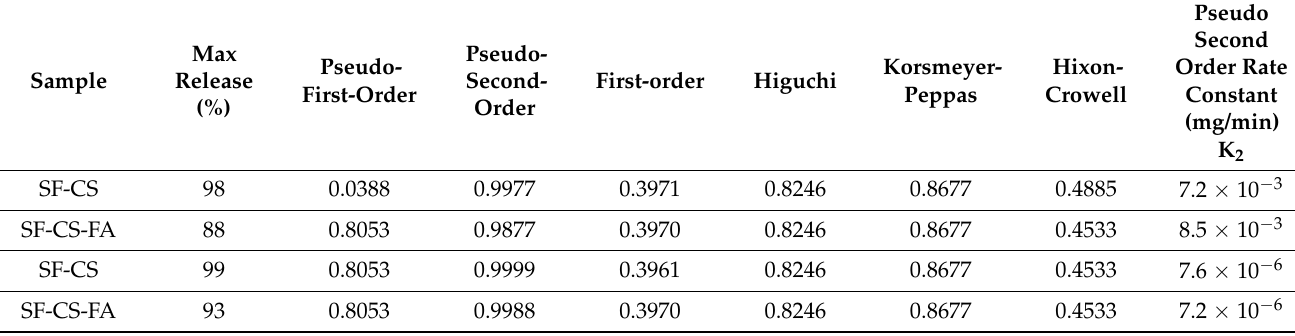
Table 5. Correlation coefficient value (R 2 ) of kinetics release of SF from its SF-CS and SF-CS-FA nanoparticles into PBS solutions at pH 7.4 and 4.8 using the first-order, pseudo-first-order, pseudo-second-order kinetics, Higuchi, Hixon-Cromwell, and Korsmeyer Peppas models and the pseudo-second-order rate constant, K 2 (mg/min).